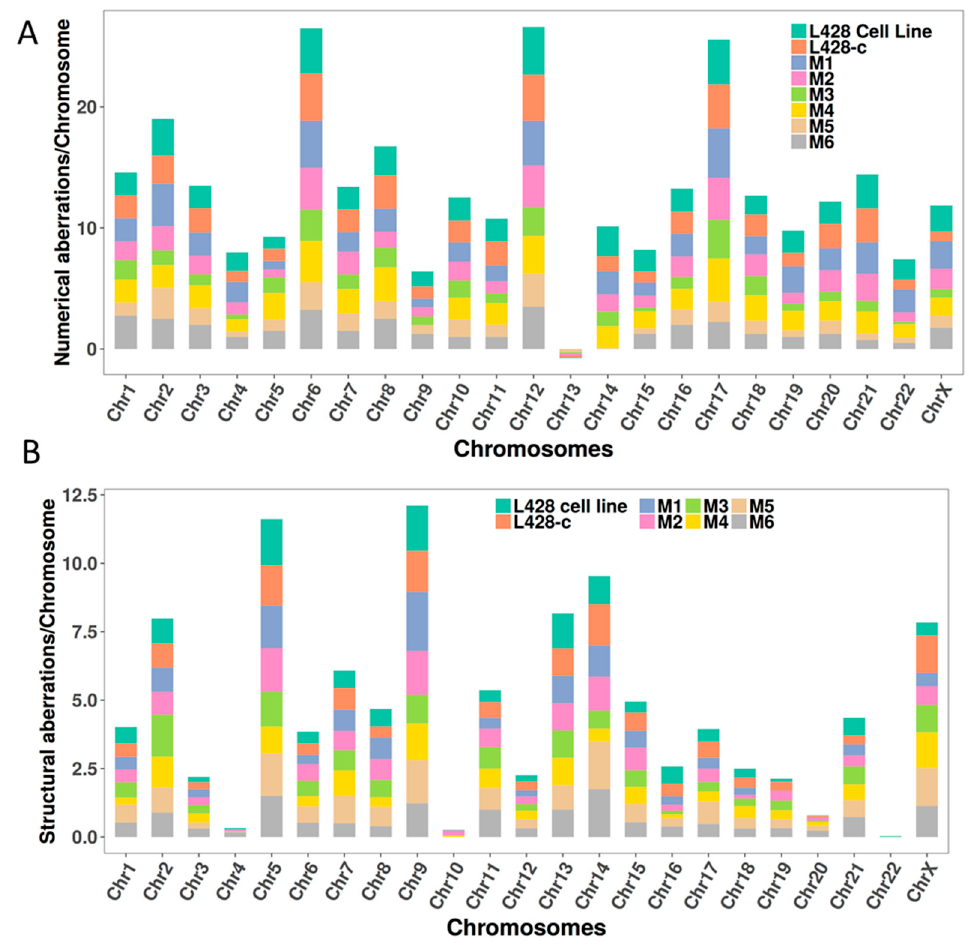
Figure 9. Chromosomal aberrations detected by telomere and centromere staining followed by M-FISH in the L428 cell line, L428-c subline, and HL cells derived from the livers of different mice (M1–M6). ( A ) Numerical aberrations (gains and losses). ( B ) Structural chromosome aberrations, including translocations, insertions, deletions, and dicentric, ring, and acentric chromosomes. Thirty metaphases were analyzed, and the chromosomes classified from each cell line.